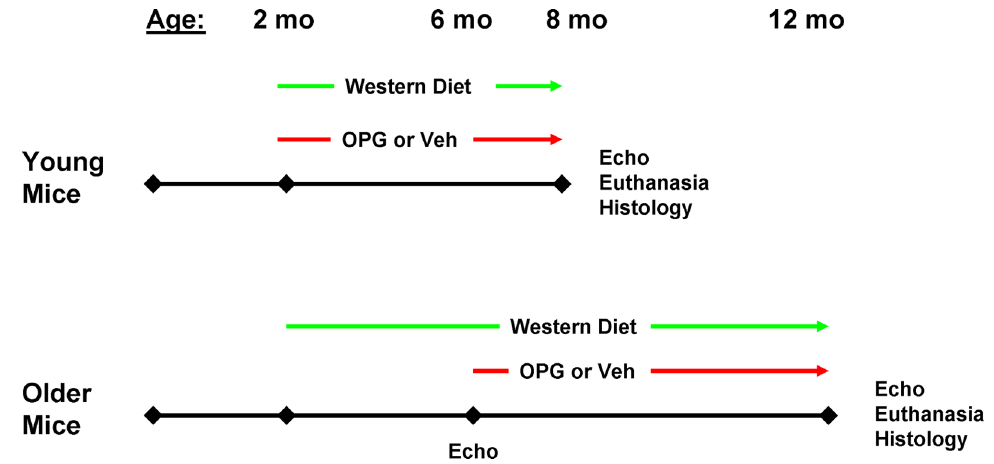
Figure 1. Experimental Strategy.